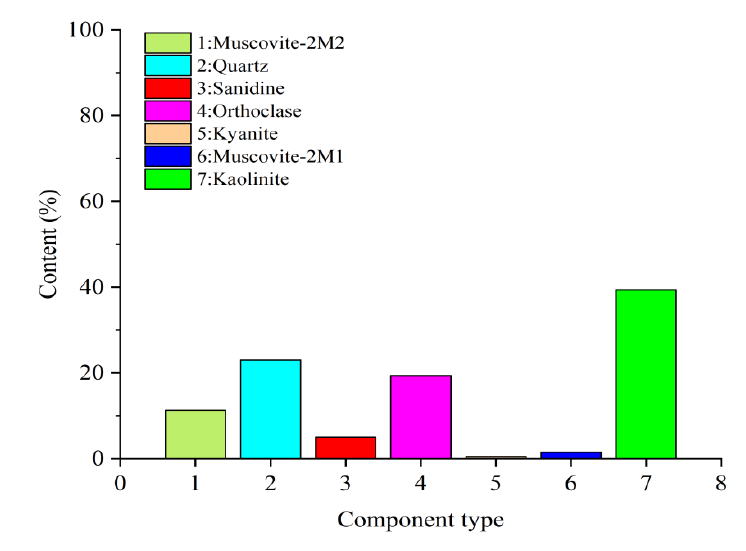
Figure 5. Composition results of XRD.